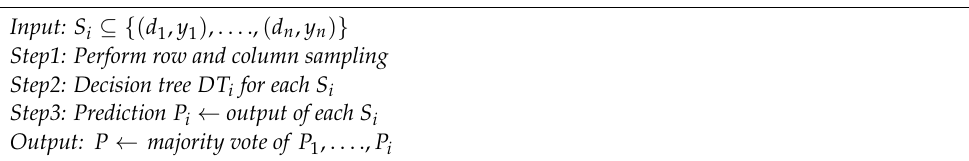
Algorithm 1: FHR Classsification using Random Forest